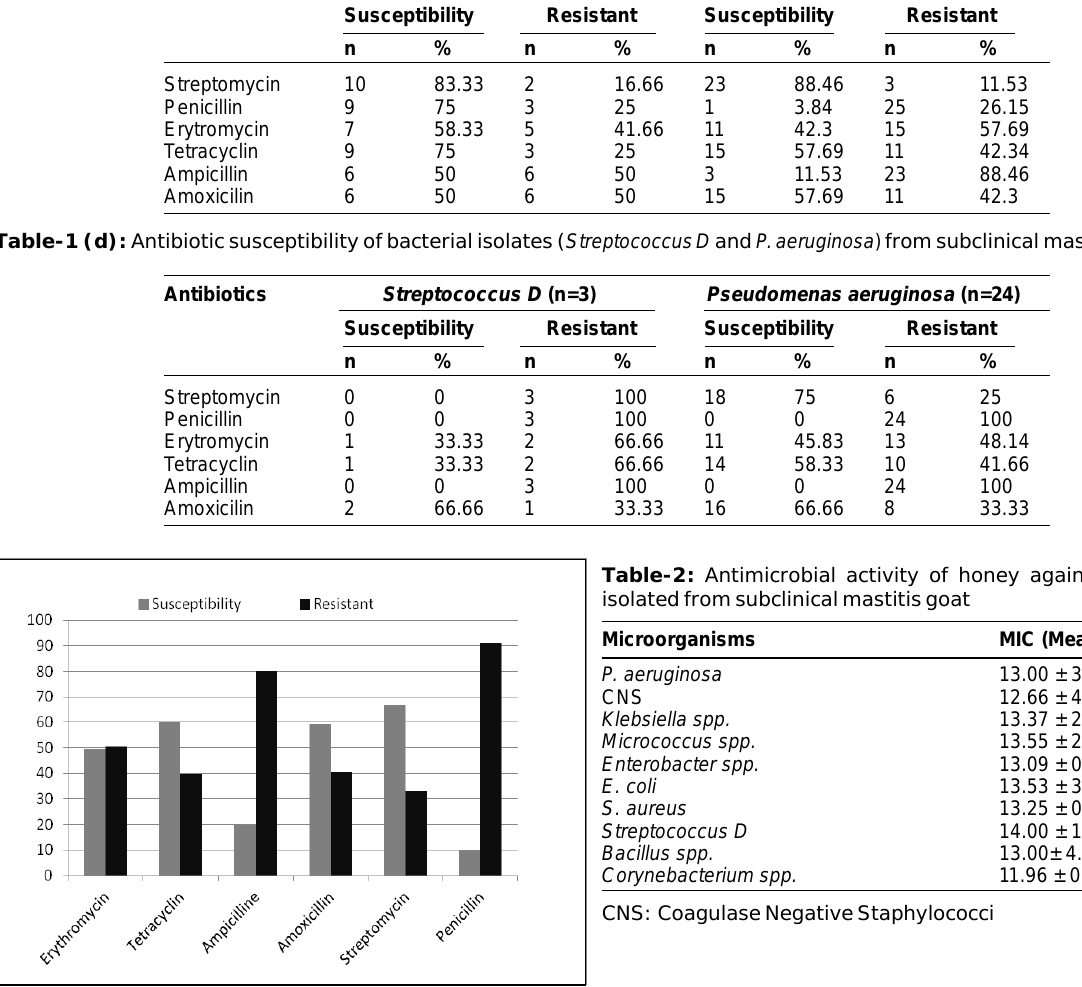
Figure-1: Percentage of resistance of strains isolated from subclinical mastitis goats.